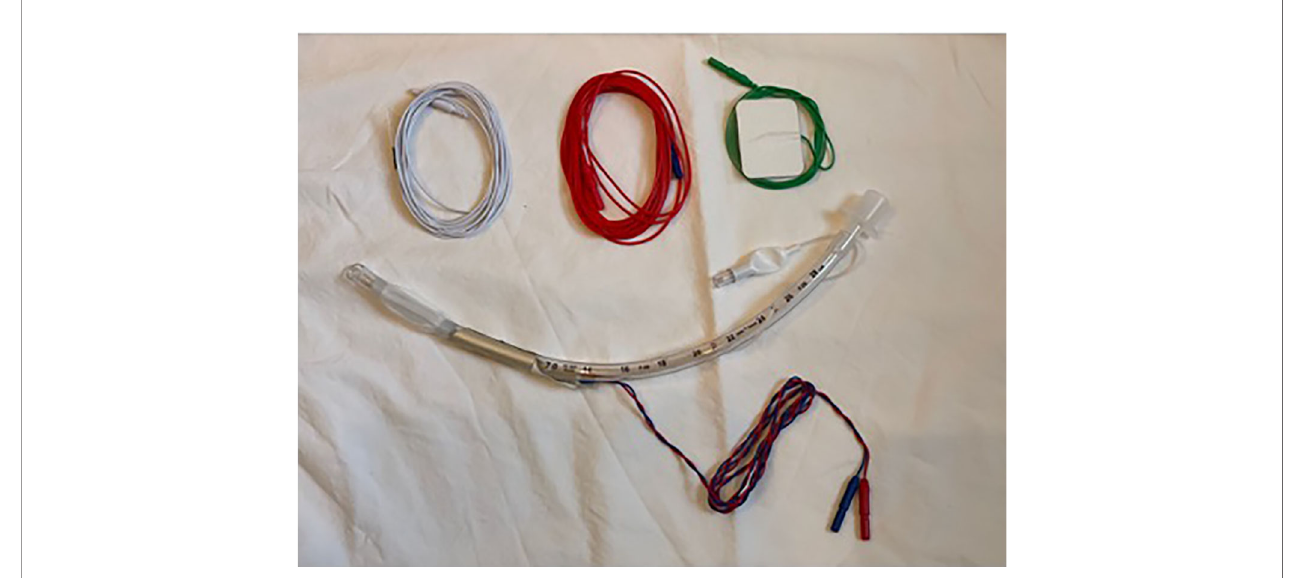
FIGURE 2 | An example of a IONM system. Adhesive electrodes are applied to an endotracheal tube and the blue and red wires are connected to a nerve monitoring system. One needle wire (white) is inserted into the deltoid muscle, a green lead wire sticker is applied to the forehead, and the single red wire connects to a handheld monopolar probe that is used to stimulate the recurrent laryngeal